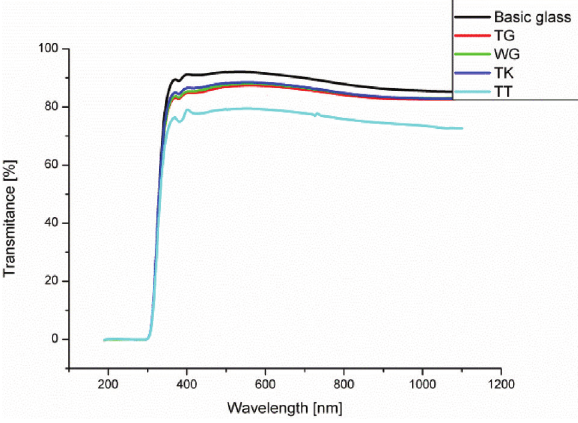
Fig. 10: Summary of transmittance curves of basic float glass and refined glass depending on